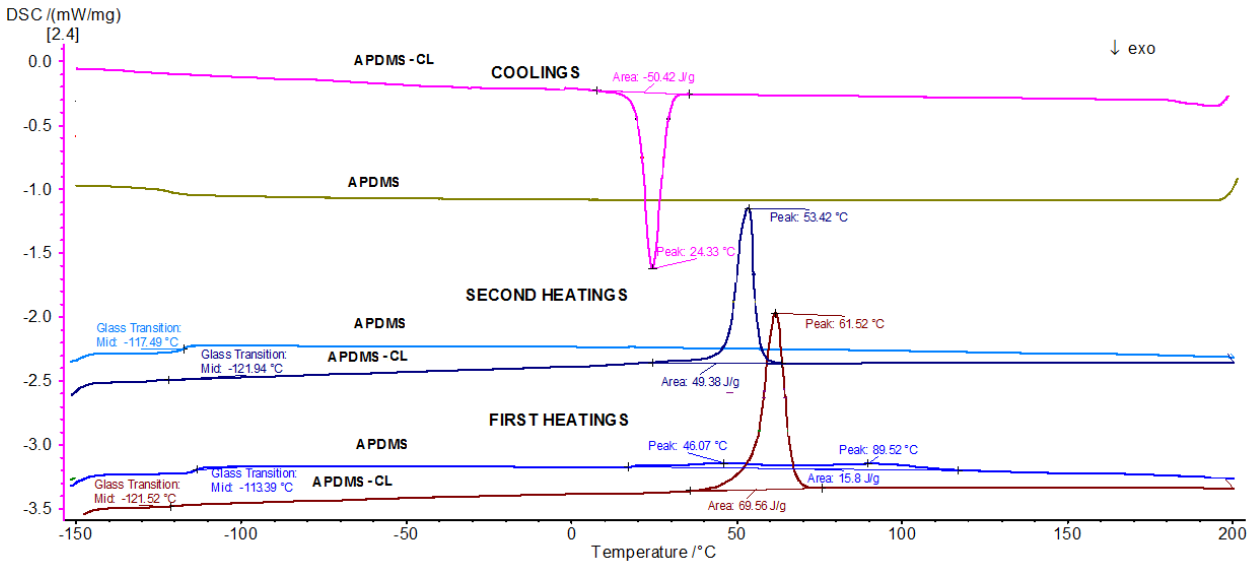
Figure 6. DSC curves of APDMS and APDMS-CL.